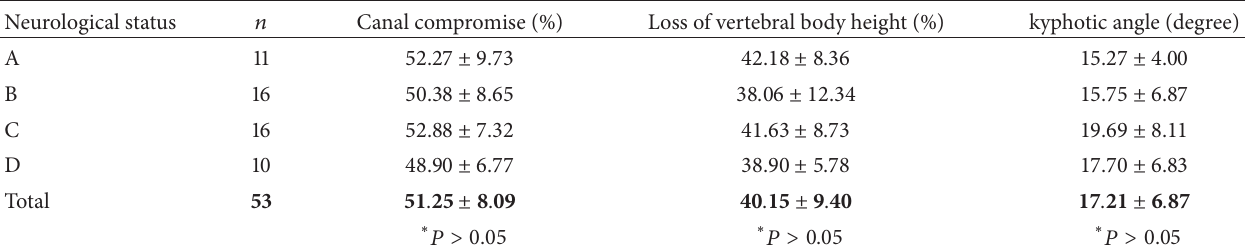
Table 1: The relationship between the level of initial neurological status with the extent of canal encroachment, the loss of vertebral body height, and the kyphotic angle, respectively.